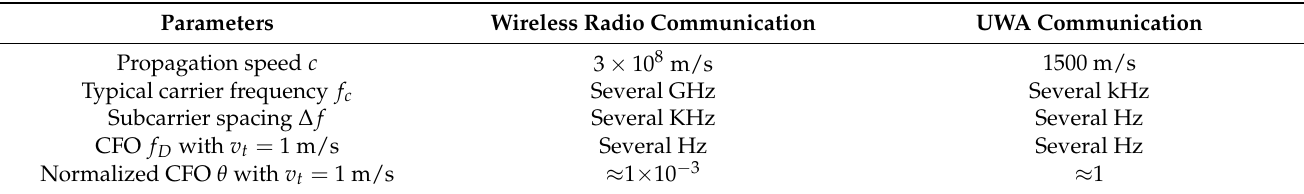
Table 1. Comparision of radio and UWA